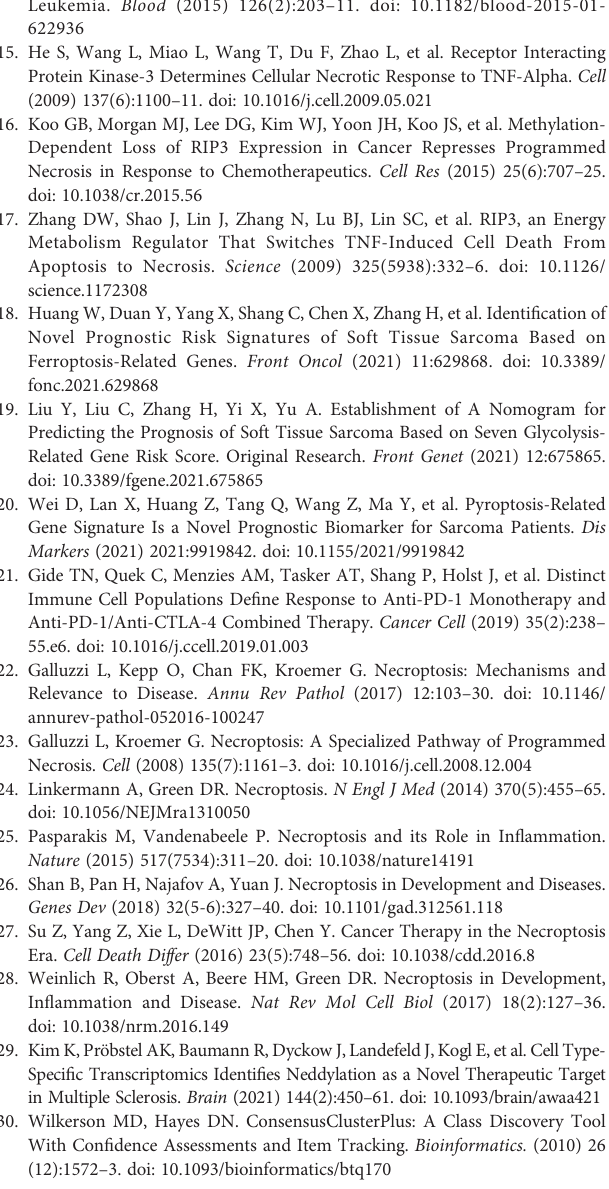
Leukemia. Blood (2015) 126(2):203 – 11. doi: 10.1182/blood-2015-01-